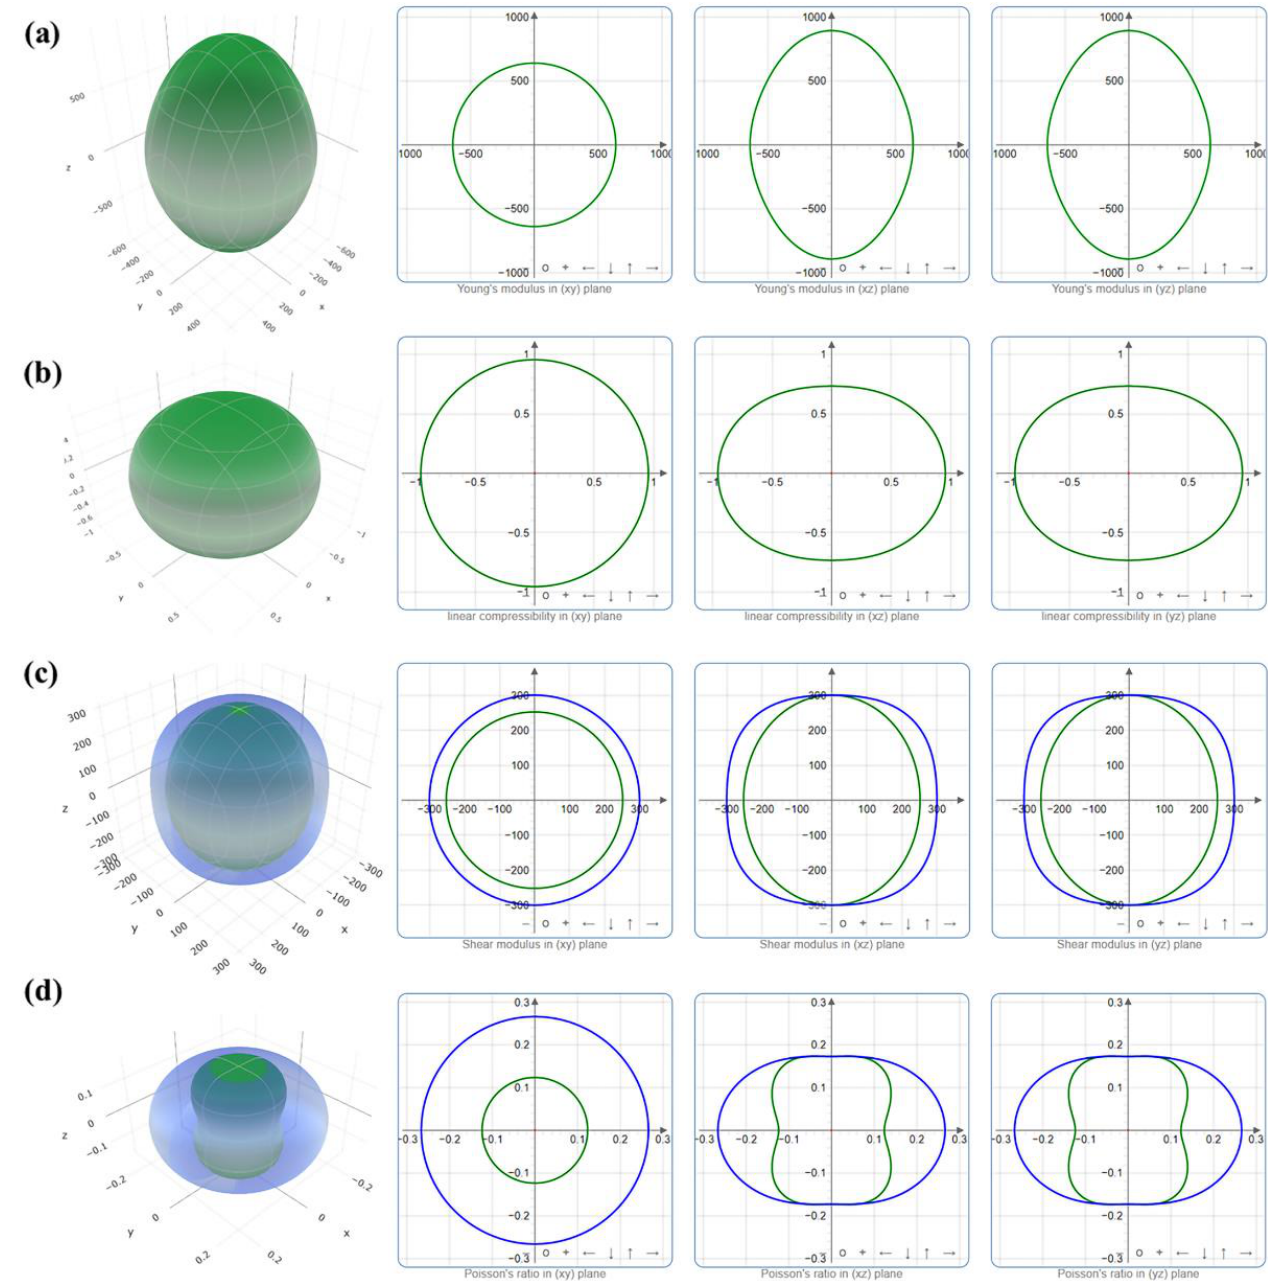
Figure 3. The 3D and 2D viewpoints of the WC bulk’s ( a ) Young’s modulus, ( b ) linear compressibility, ( c ) shear modulus, and ( d ) Poisson ’ s ratio.